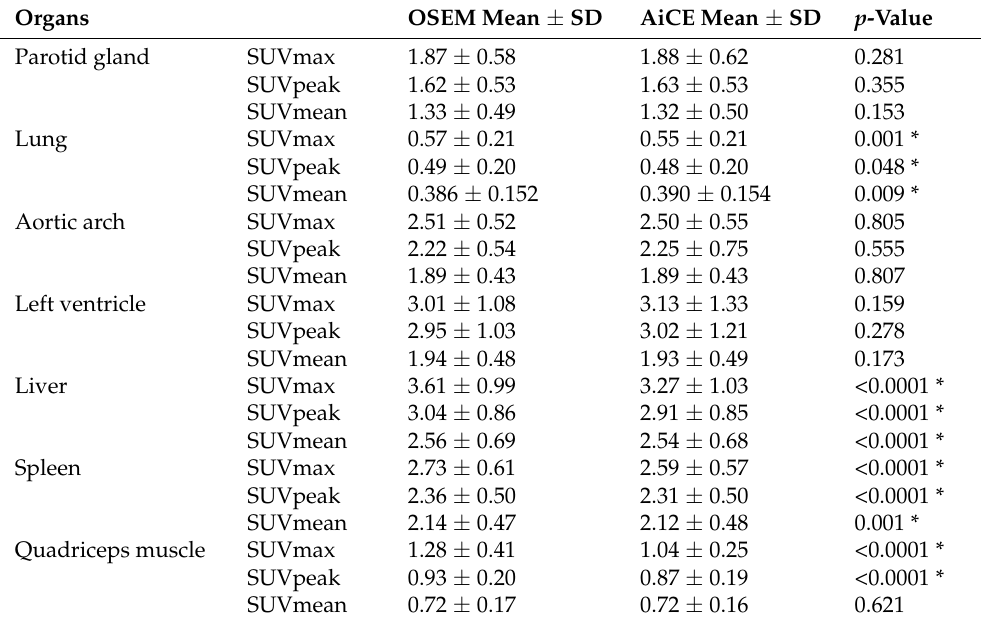
Table 3. SUVs in healthy organ tissues.